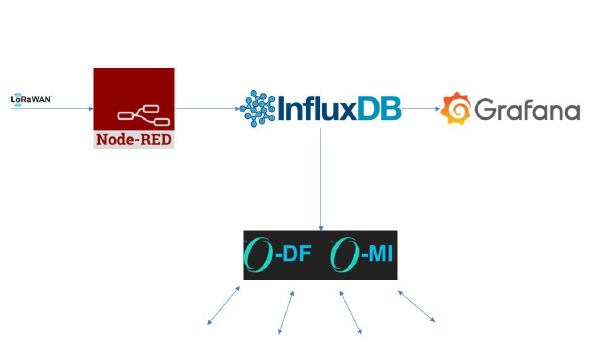
Figure 8.Temperature sensor network Architecture (Part 2).